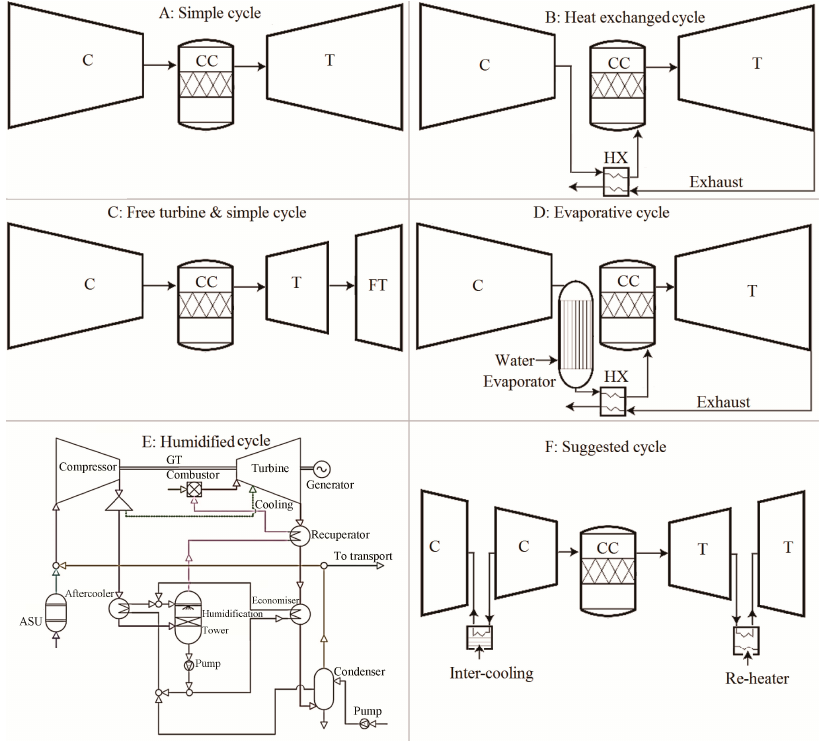
Figure 1. Schematic diagrams of the cycles (C, CC, T, FT, HX, GT, and ASU stand for compressor,